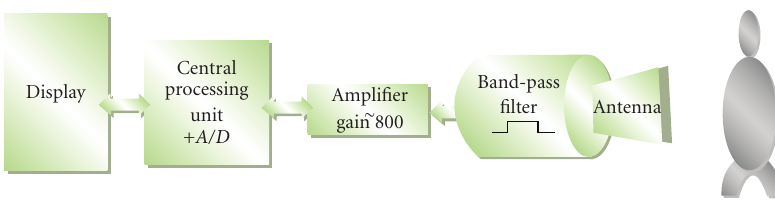
Figure 5: Block diagram of the principle design of the contactless MCG device.